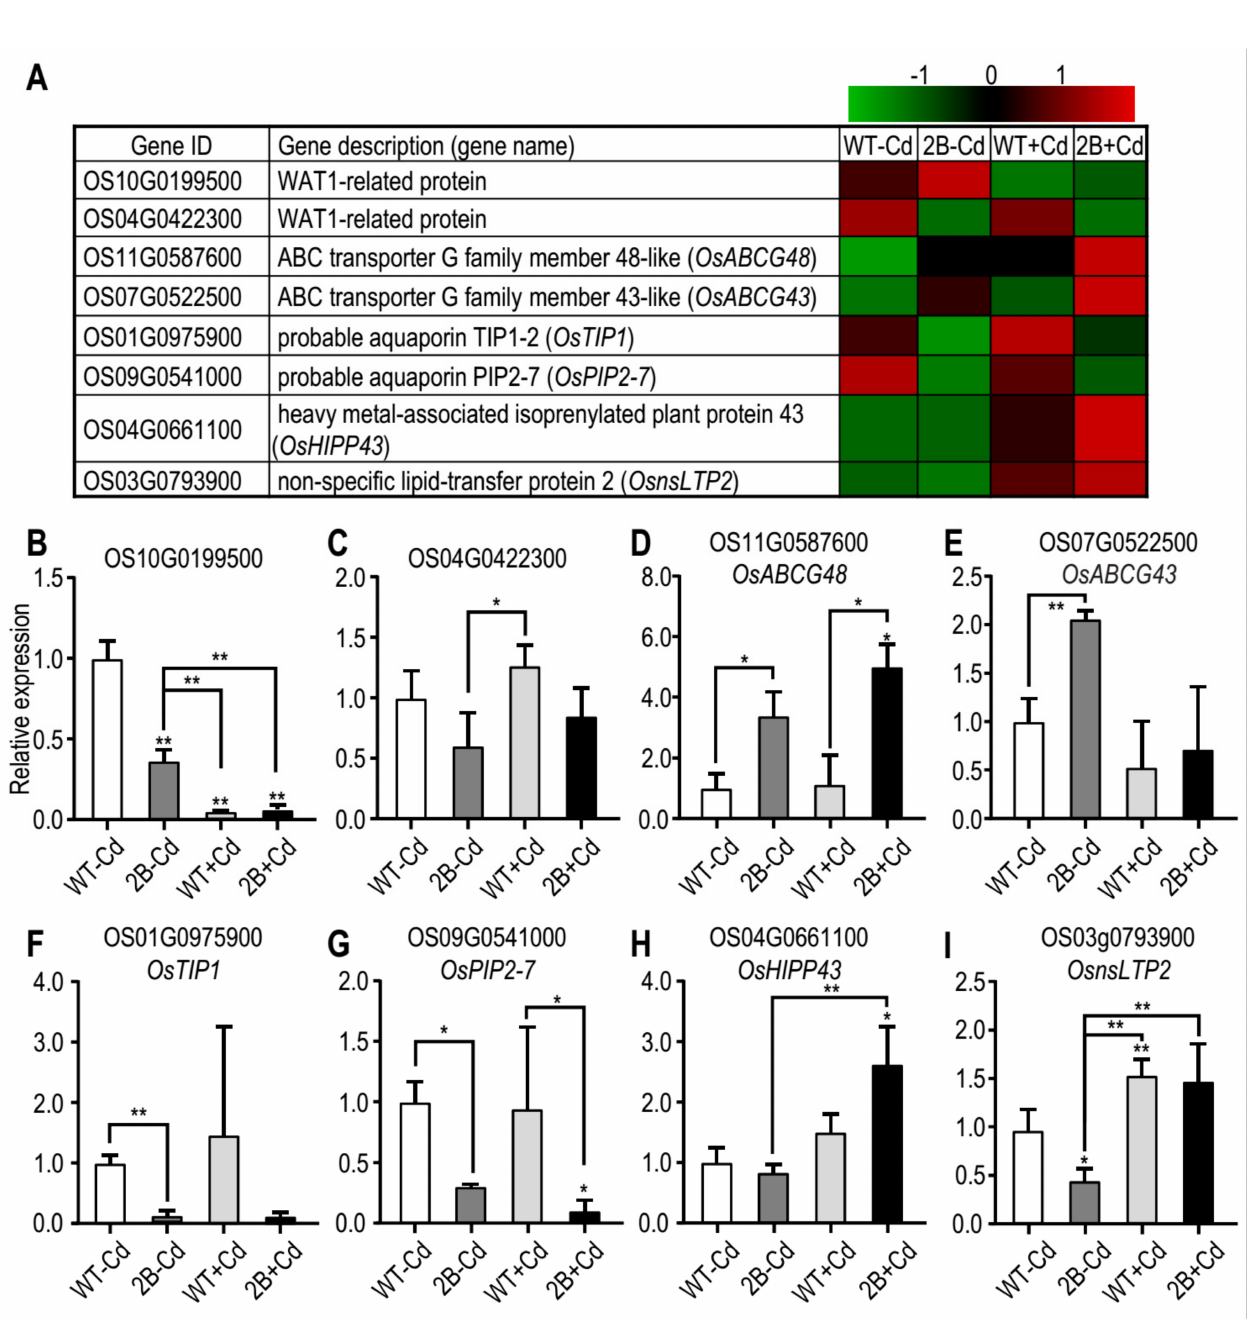
Figure 2. RNA-seq and qRT-PCR comparisons of candidate transporter genes. ( A ) DEGs with transporter-associated activity identified by RNA-seq. Green to red color scale indicates down- to upregulation. ( B – I ) qRT-PCR of gene expression normalized to OsActin-1 . Data (bar and error bar) are shown as mean ± SD ( n = 3). Unpaired Student’s t -test used for statistical significance (* p < 0.05, ** p < 0.01) of samples indicated on top of connecting lines, or by comparison to WT − Cd indicated on top of error